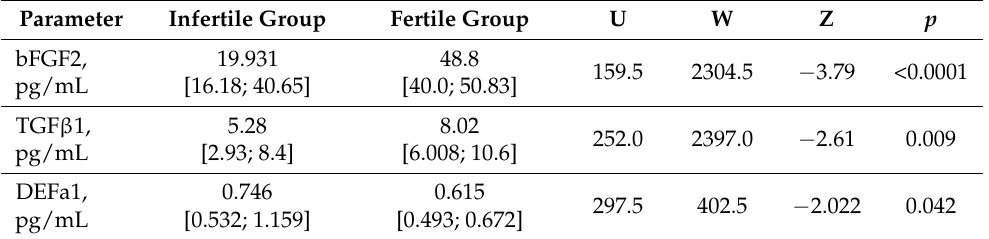
Table 2. Endometrial TGF β 1, bFGF2, and DEFa1 concentrations in the investigated